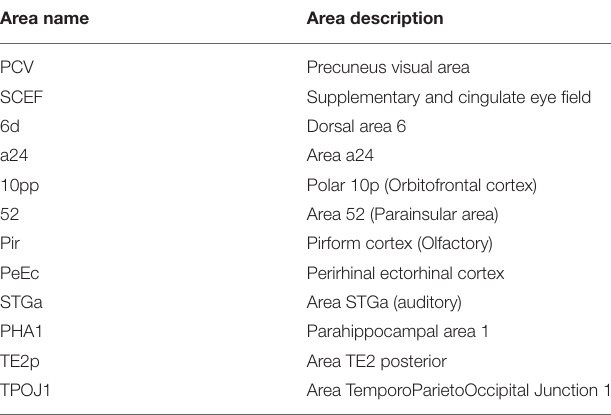
FIGURE 3 | Bilateral frequently selected features. Bilateral cortical regions from the 60 most frequently selected parcels used to train the SVM model using BC + CC + DC and an Enet-subset feature selection method are highlighted on a cortical mesh surface of the left hemisphere. Right hemisphere is not shown. Cortical regions are outlined in green and labeled according to the abbreviations in Table 4 . Frequency of selection is indicated in red. TABLE 4 | A summary of the bilateral regions from the top 60 cortical regions, selected for by frequency, that contributed to the classification accuracy of the Enet-subset model when trained using the betweenness centrality, degree centrality, and clustering coefficient graph